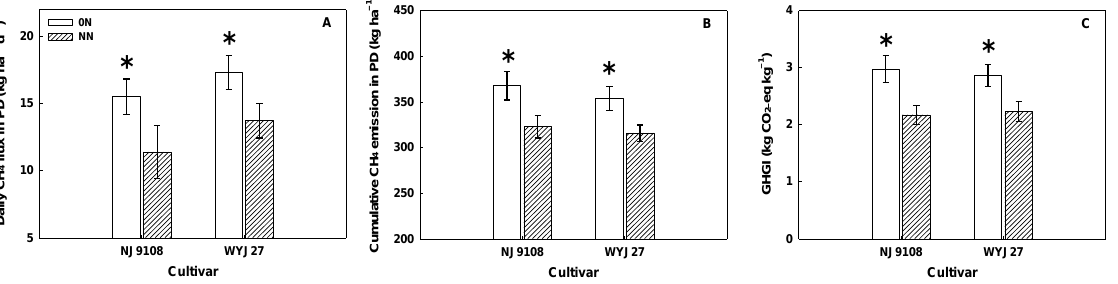
Figure 6. Effect of nitrogen application at panicle differentiation stage on daily CH 4 flux ( A ) and cumulative CH 4 emissions ( B ) in panicle differentiation stage and GHGI ( C ). 0N: no nitrogen application; NN: nitrogen application rate at 120 kg ha −1 . * indicates statistical significance within the same rice cultivar at p < 0.05 level.